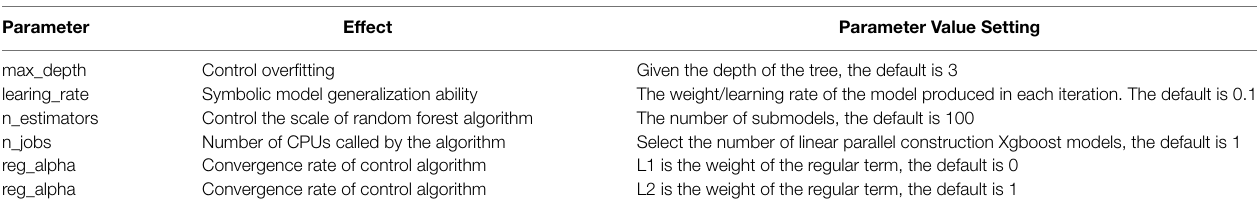
TABLE 1 | XGBoost various parameters. Parameter max_depth Control